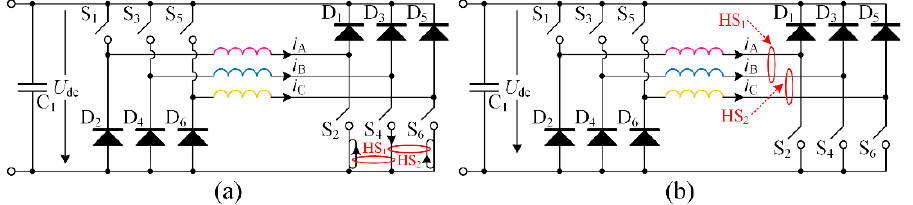
Figure 18. The proposed ( a ) and the baseline ( b ) schemes using two multiplexed hall effect sensors for the three-phase SRM.